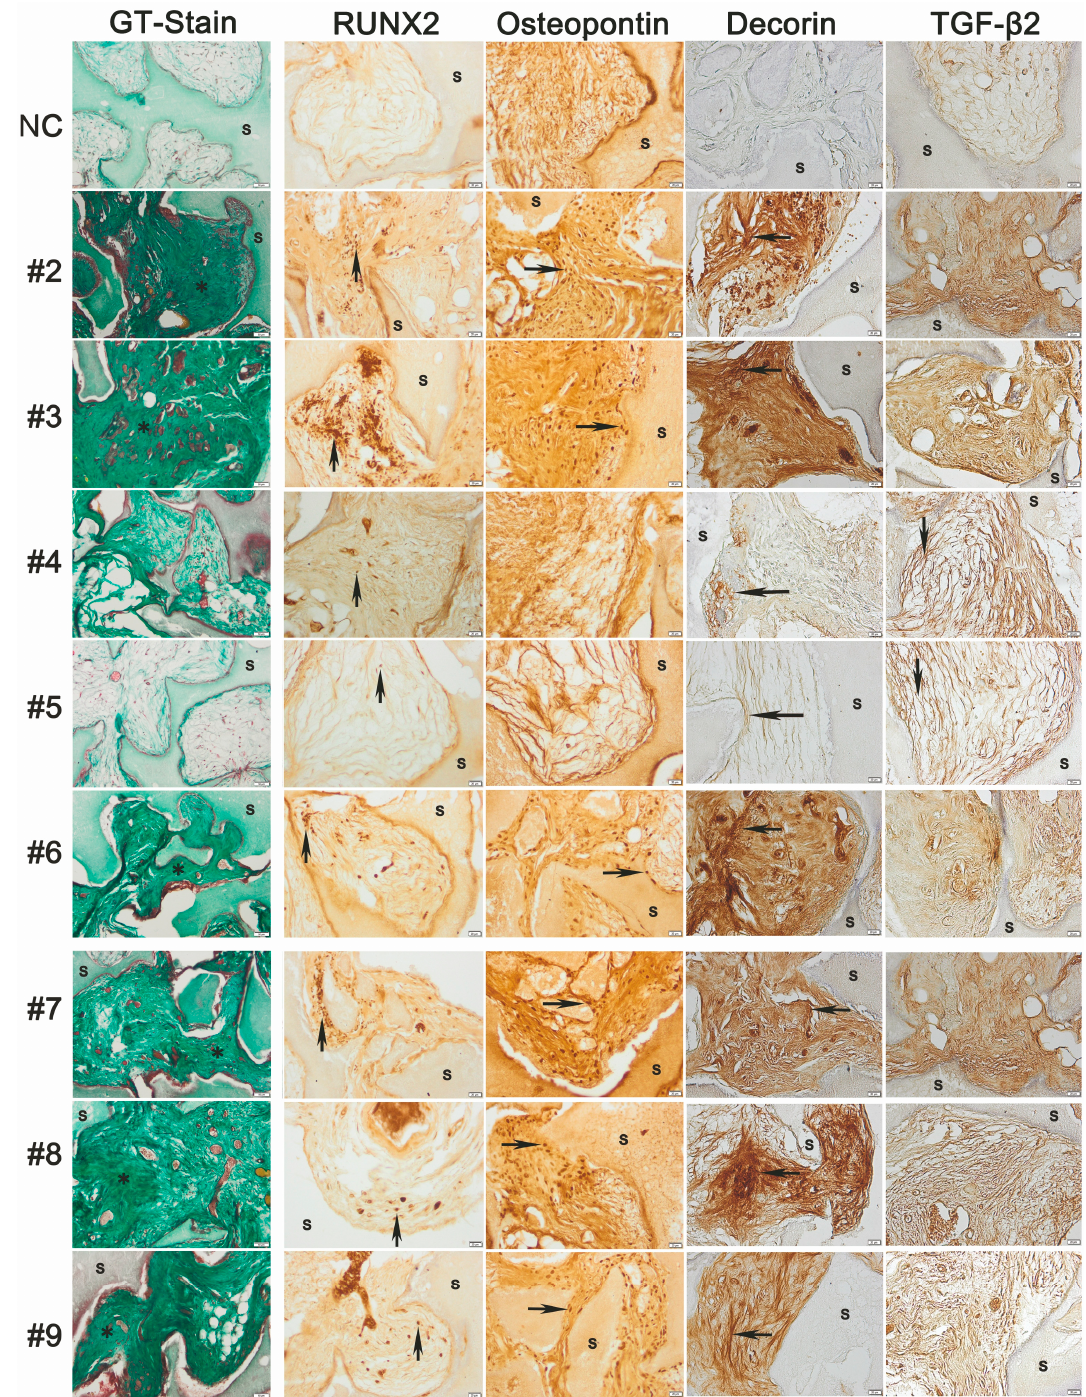
Figure 9. Histological analysis of inter-donor heterogeneity for in vivo osteogenic di ff erentiation of hMSC derived from hBM-MSC donors #2–#6 and hAT-MSC donors #7–#9 implanted for 8 weeks with HA / β TCP sca ff old (s) stained for osteoid / bone (*) with GT (Gomori’s trichrome stain). Negative control (NC) sections involved sca ff old implants without human cells. Peroxidase immunohistochemical staining (brown) detected cells positive for the nuclear transcription factor RUNX2 (up arrow), Osteopontin (right arrow), human-specific decorin that densely stained cells from bone-forming donors (left arrow) and TGF- β 2 protein that was di ff usely present in the extracellular matrix of bone-forming cells and more distinctly stained the matrix of non-bone-forming (down